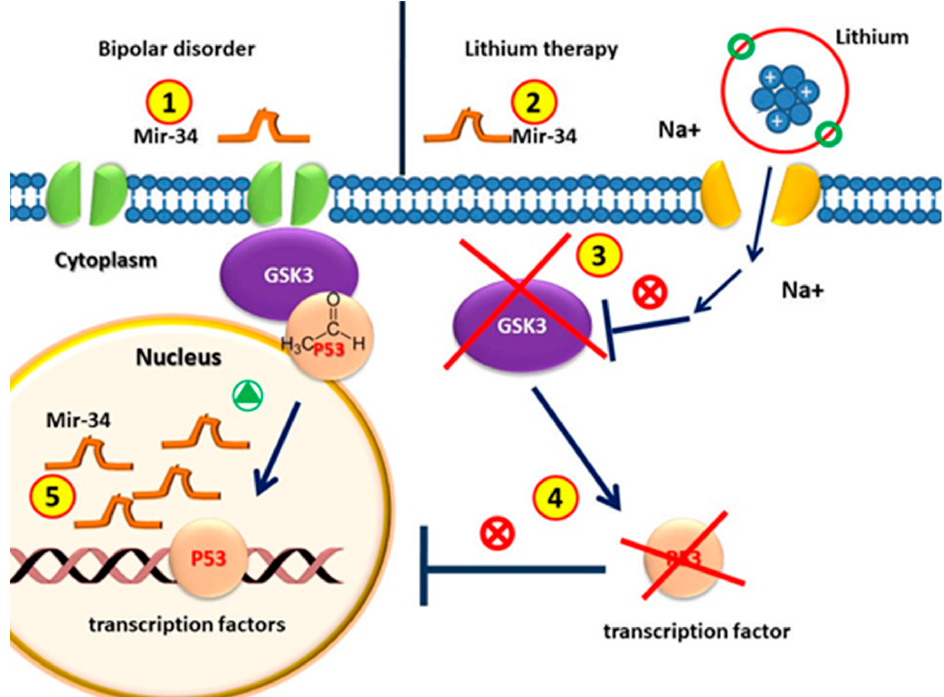
Figure 3. Circulating MiR-34 in patients with bipolar disorder is higher than that in healthy individuals. (2) MiRNA-34 levels decrease after lithium treatment. (3) GSK3 β is the therapeutic target of lithium in the treatment of BD. (4) GSK3 β is involved in the regulation of gene expression by phosphorylating p53; the pharmacological inhibition of GSK3 β with lithium counteracts p53 activity. (5) Since p53 induces the transcription of miR-34, without p53, the amount of MiR-34 in patients with lithium treatment